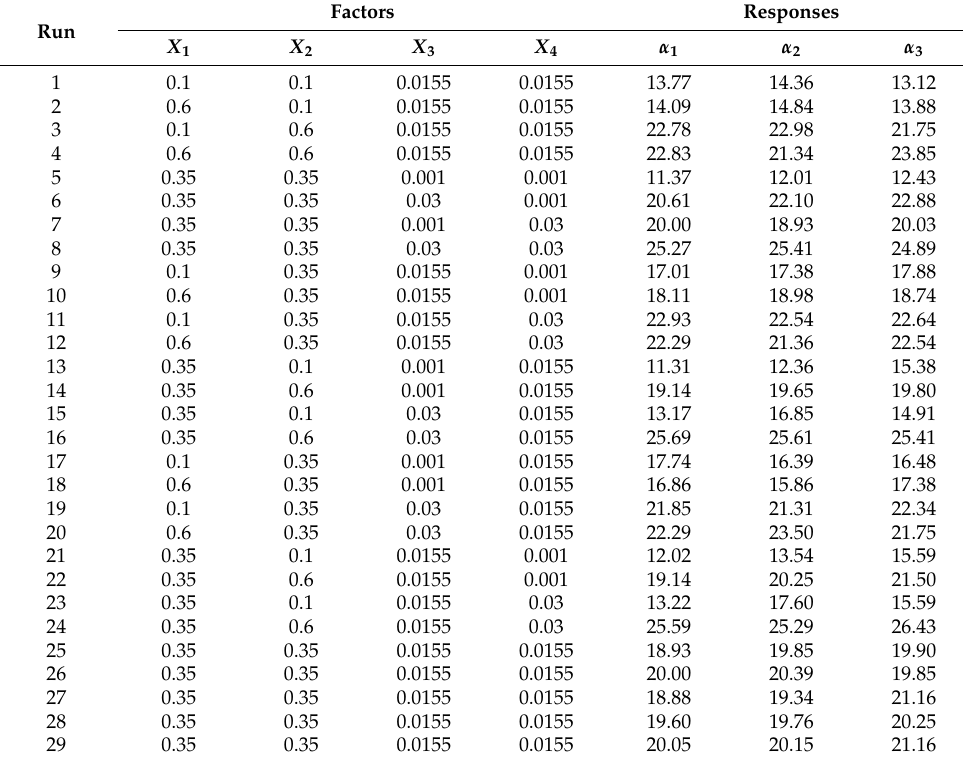
Table 6. Scheme of the Box–Behnken design test and the simulation results. Run